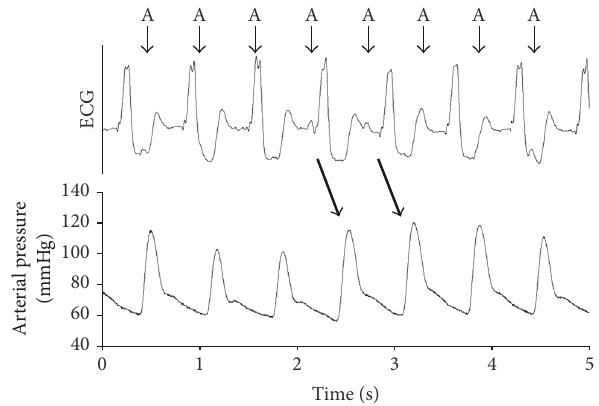
Figure 2: Relationship of sinus and paced cardiac activity and its effect on arterial pressure. The ECG strip shows a paced ventricular “regular” rhythm, where atrioventricular dissociation is still present. The small arrows indicate atrial activity (“A”). The coincidence of normal AV sequence results in substantial arterial pressure augmentation (indicated by the thick arrows). For more details, read the text.